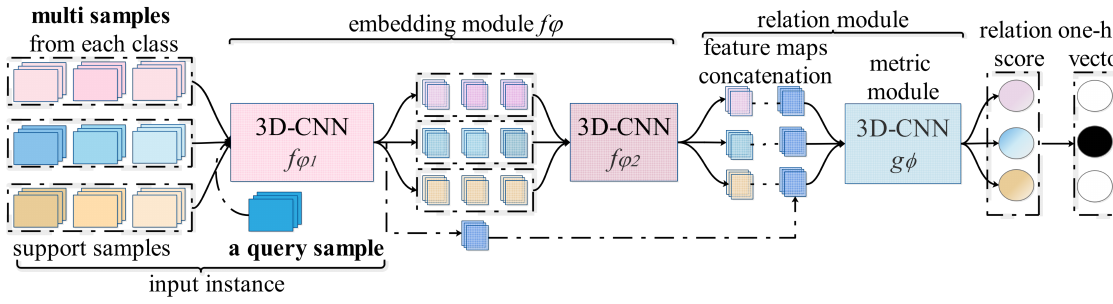
Figure 2. An example of SS-RN architecture for hyperspectral image classification.